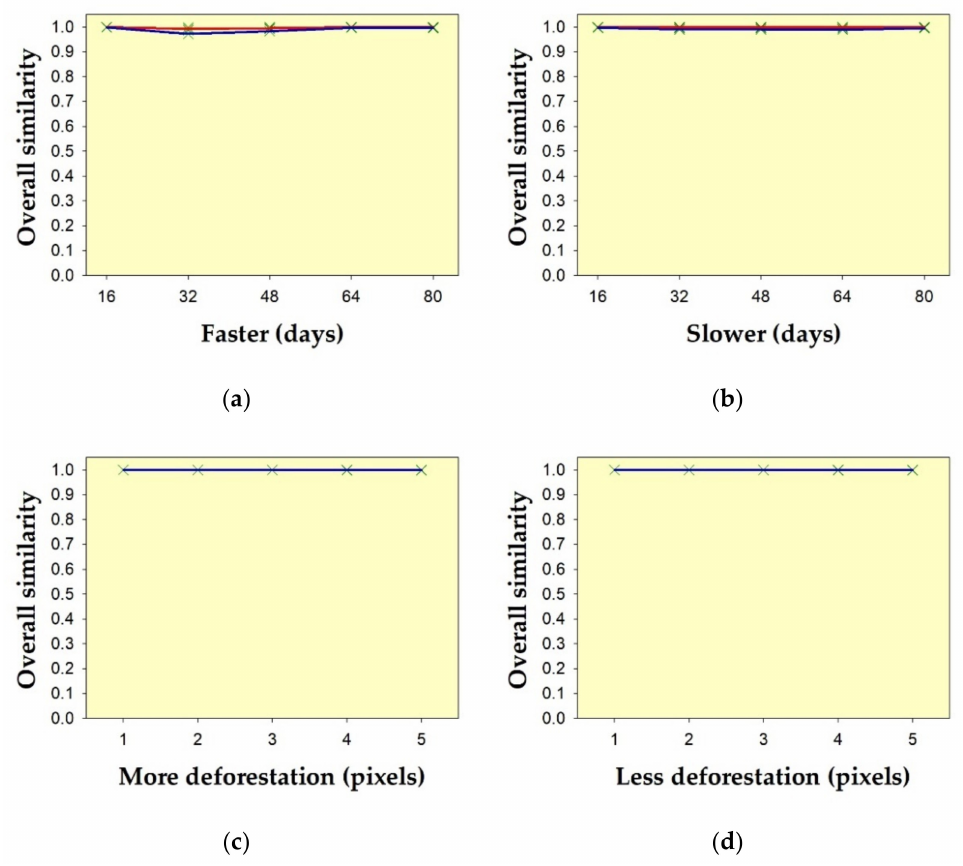
Figure 24. Sensitivity of the method on hypothetical temporal data sets on deforestation after inter- polation at a time slice of 1 min, due to the possibility of ( a ) acceleration, ( b ) delay, ( c ) overestimation, and ( d ) underestimation of deforestation detection, compared to the reference. Green crosses indicate overall similarity (i.e., the average of θ and δ similarities) from all nine metrics. Red lines on the upper edge of the envelopes indicate the overall similarity using the Fidelity metric. Blue lines on the lower edge of the envelopes indicate the overall similarity using the metric of Soergel–Ruzicka–Tanimoto.